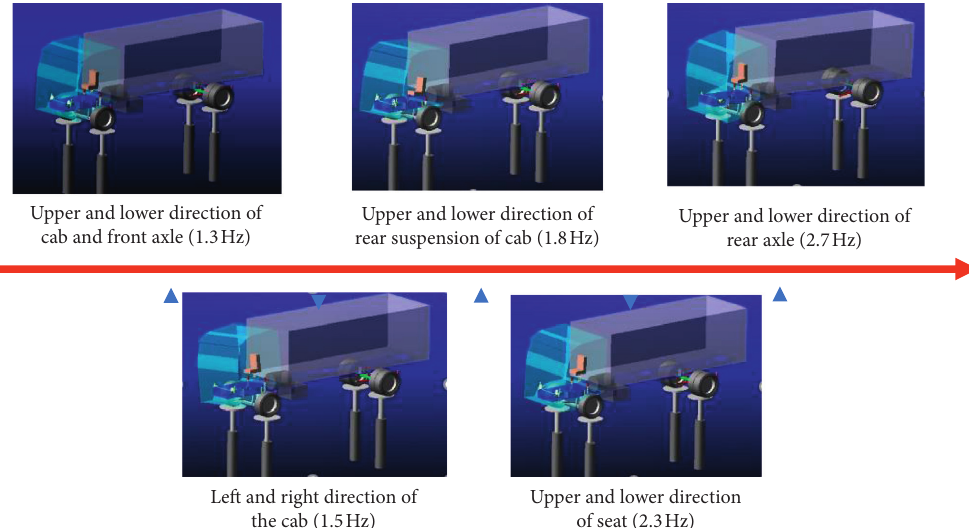
Figure 10: Partial modal shapes and frequencies of body parts.